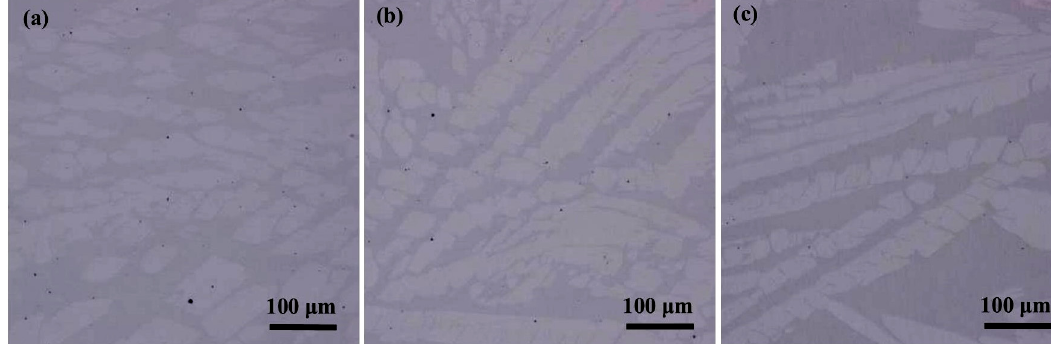
Figure 3. The OM photographs of inclusions in the 0#–2# experimental samples: ( a ) 0#; ( b ) 1#; ( c ) 2#.